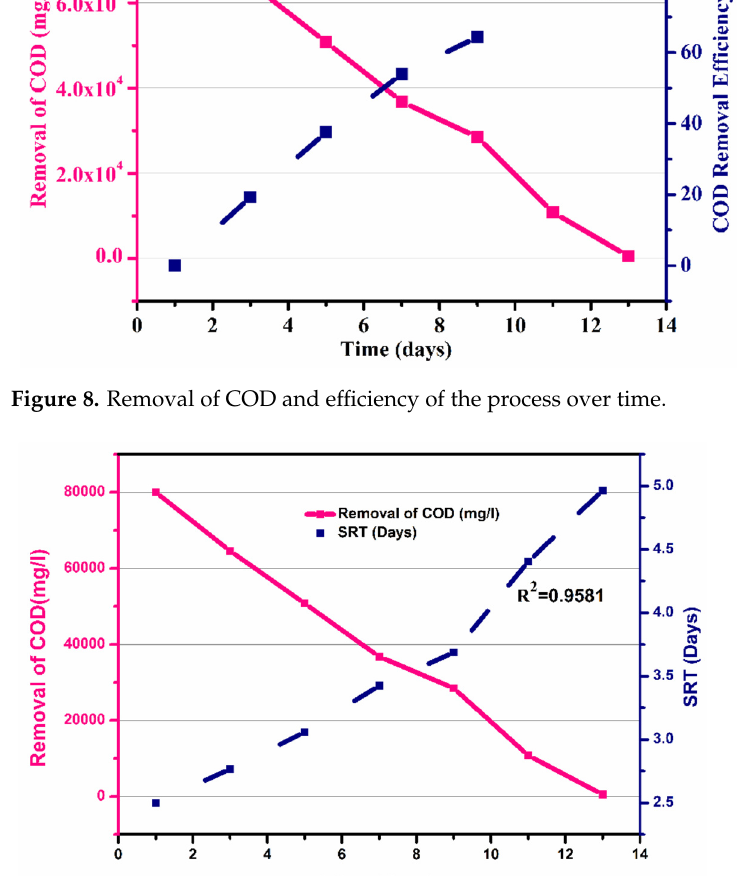
Figure 9. Solid retention time of the process over time. Table 6. Kinetic parameters obtained by removal of COD for industrial beverage